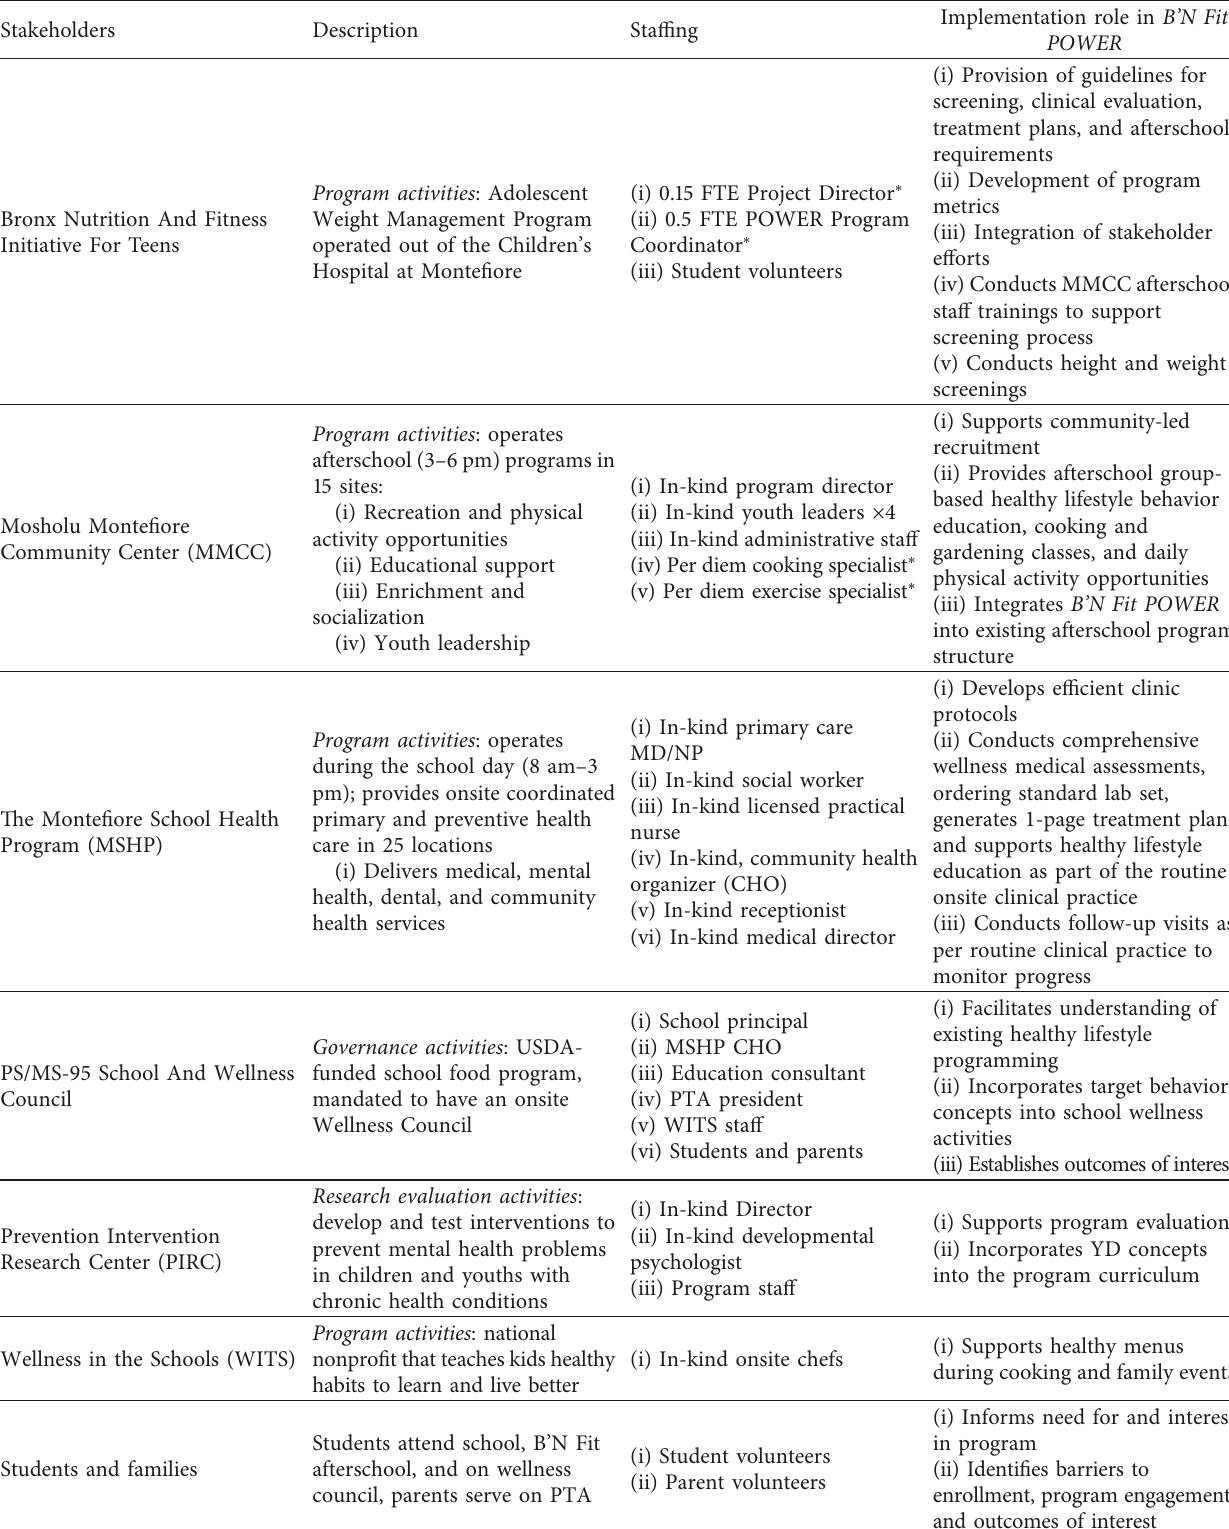
Table 1: Contributing stakeholders and their role in the B’N Fit POWER